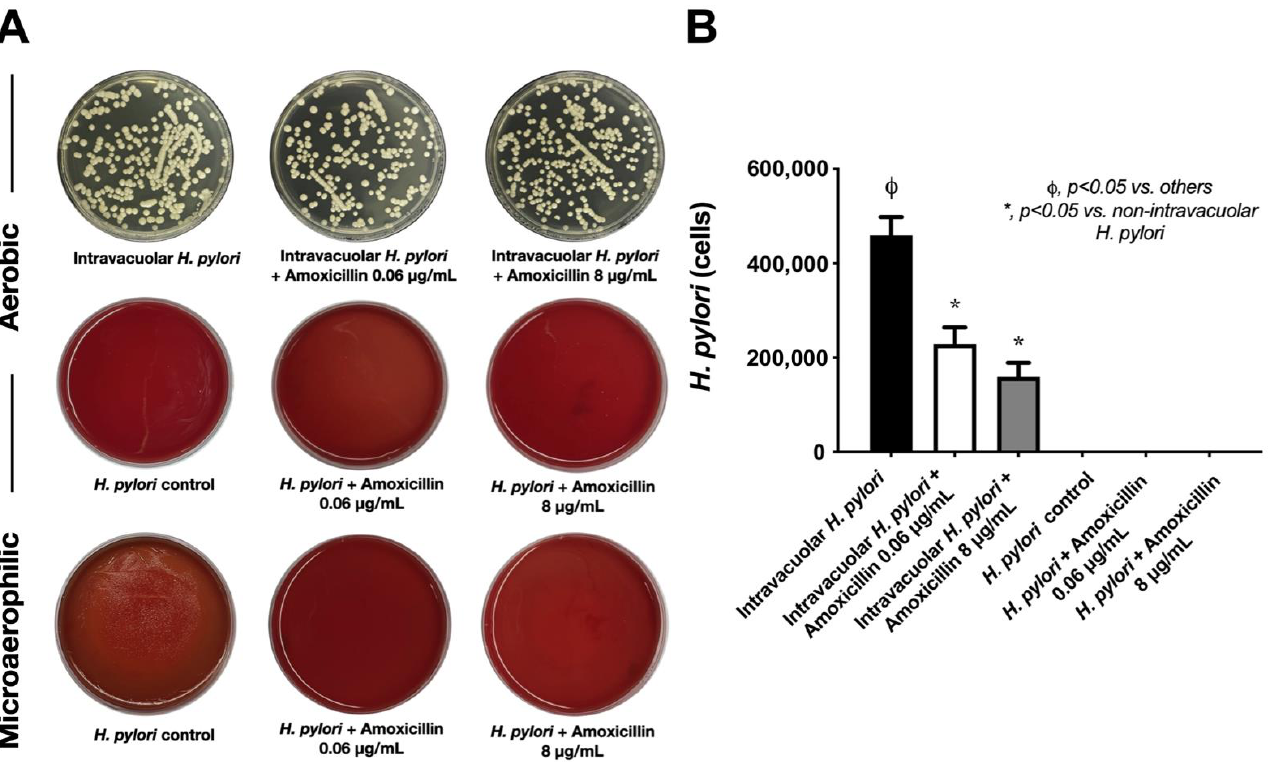
Figure 4. The protection of H. pylori by Candida . Representative pictures of the culture plates of second-generation intravacuolar H. pylori inside C. albicans co-incubated on SDA for 24 h with or without amoxicillin at 0.06 and 8 ug/mL ( A upper); in addition, the culture plates of extracellular H. pylori in Columbia blood agar after 24 h of aerobic conditions ( A middle) and microaerophilic conditions with amoxicillin ( A lower) are shown. Additionally, H. pylori bacterial abundance based on CagA gene expression in these conditions is also shown ( B ). Independent triplicate experiments were performed. *, p < 0.05 vs. non-intravacuolar H. pylori ; φ , p < 0.05 vs. others, as calculated by ANOVA with Tukey’s analysis .